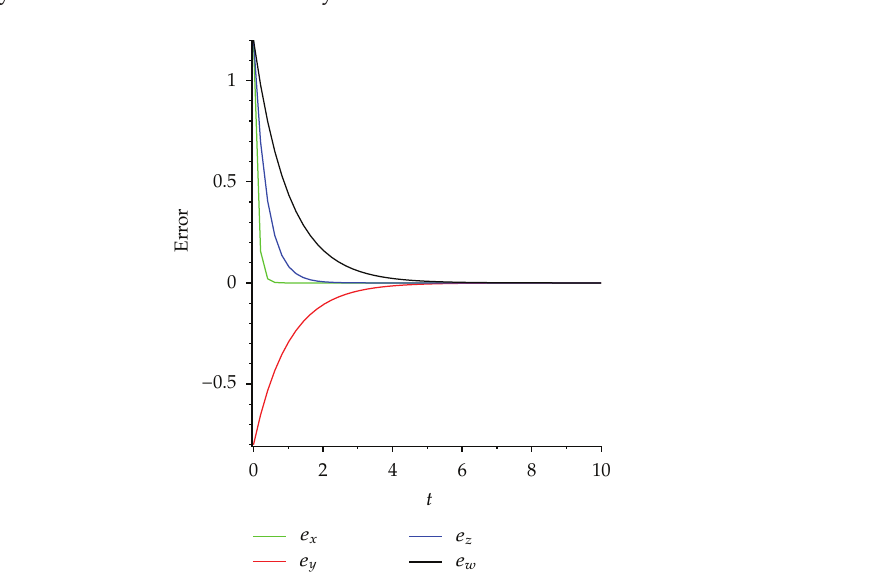
Figure 3: It shows that the behaviour of the trajectories e x , e y , e z , and e w of the hyperchaotic Lorenz system error system tends to zero as t tends to 5 when the scaling factor α (cid:8) − 2.